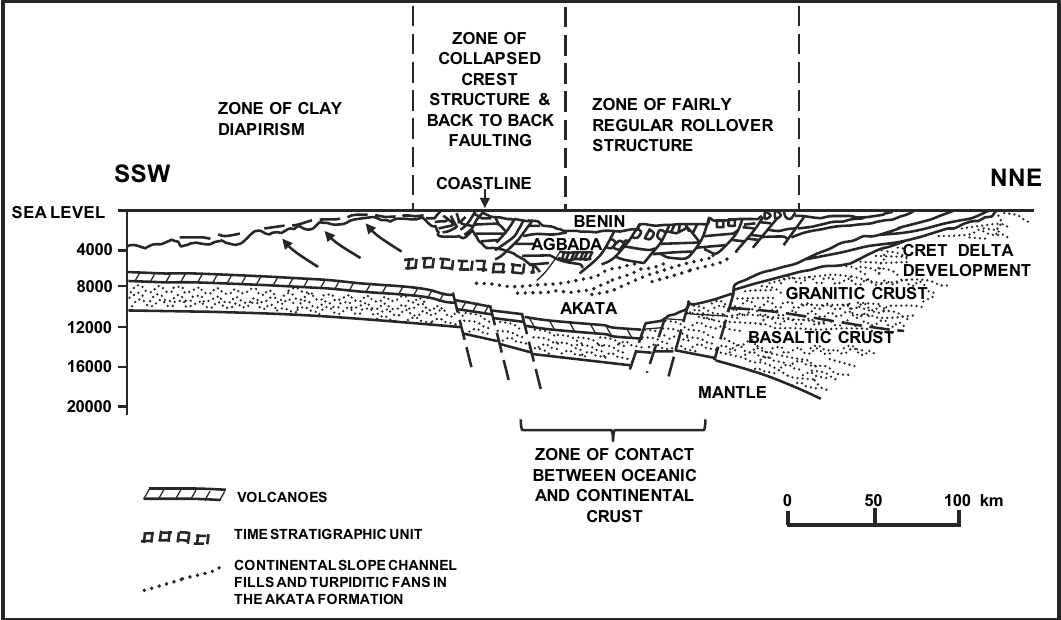
Fig. 2 Schematic dip section of the Niger Delta Basin showing stratigraphic successions. (Redrawn from Whiteman